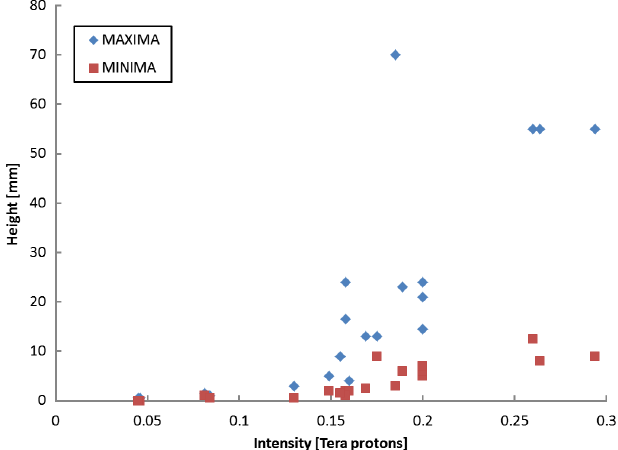
shots.VIDEO 5. Shot 10, 76 ms after beam pulse. The arrows highlight tails of the primary disruption settling whilst the circles highlight the two secondary disruptions